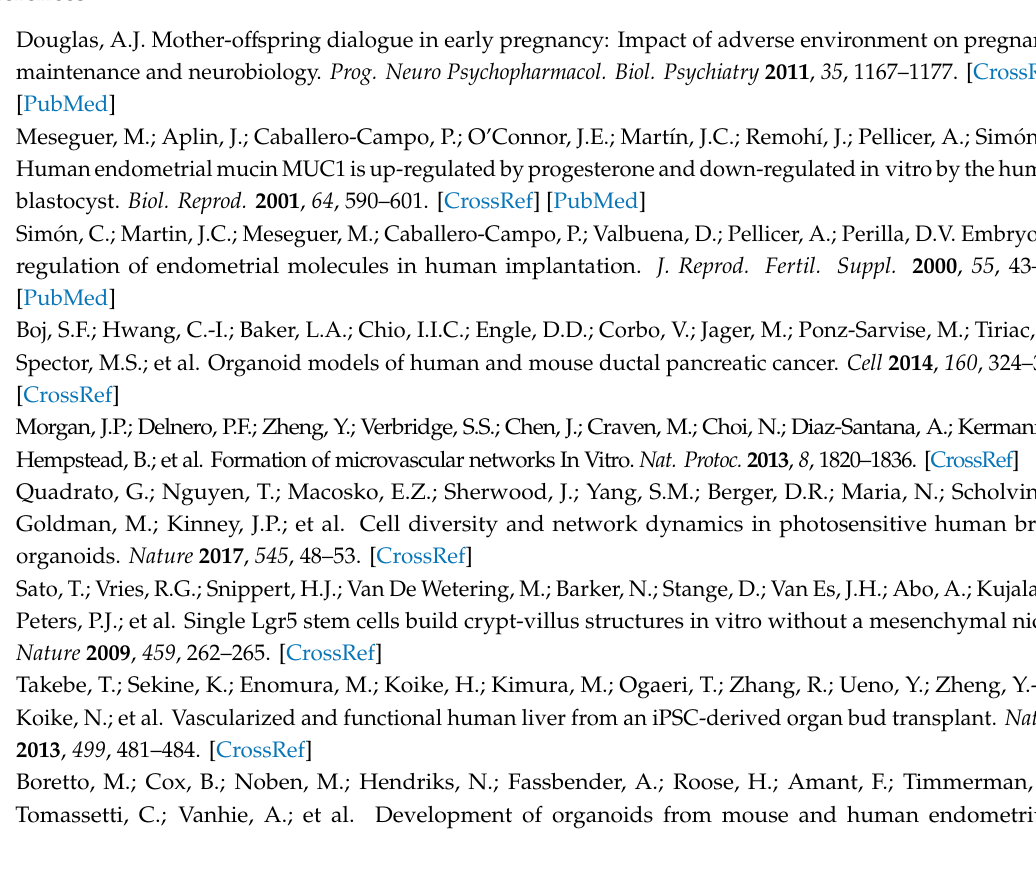
Table S1; PrimePCR ™ Expression Probe Assay, specific for Droplets Digital Polymerase Chain Reaction. Figure S1: Ultrastructure of epithelial glandular organoids in endometrium from patients a ff ected by